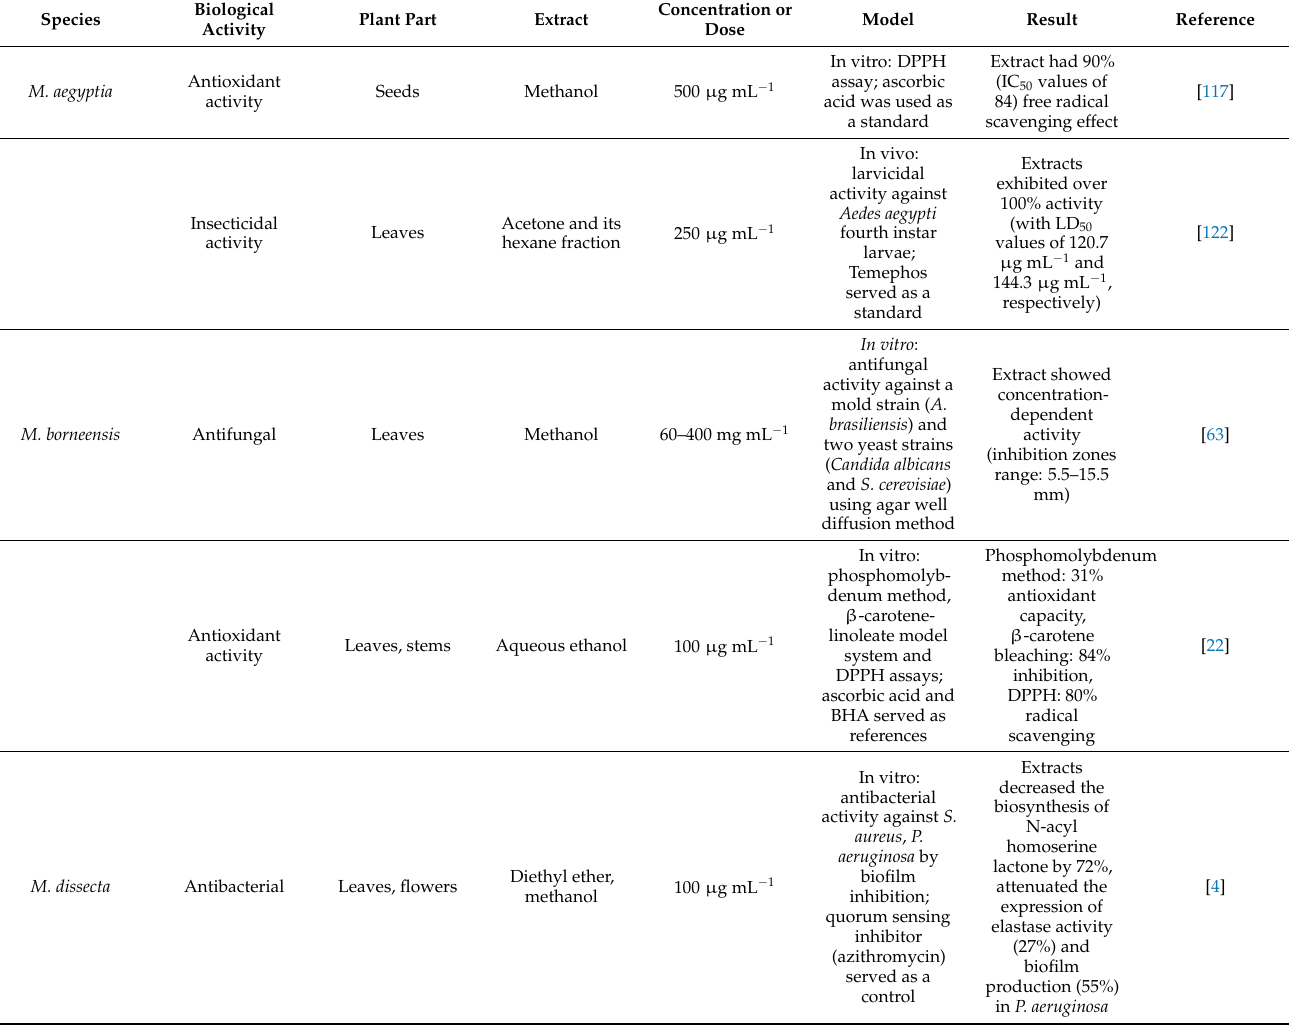
Table 6. Summary of the biological activities of Merremia